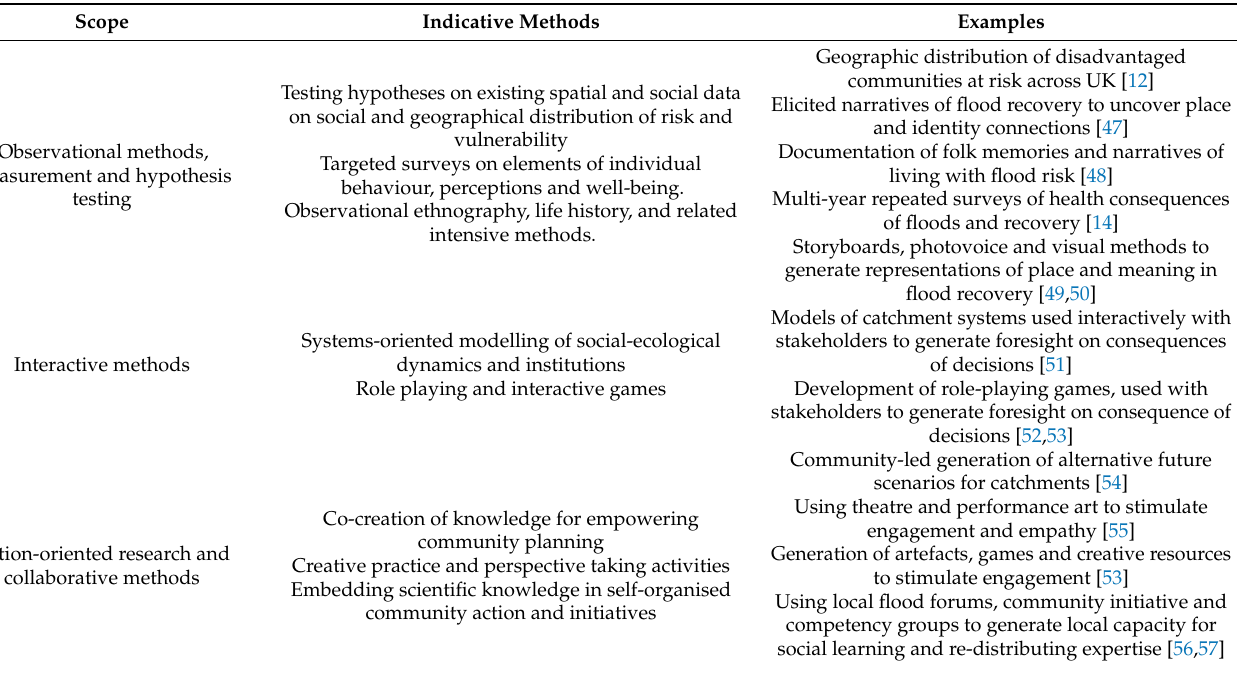
Table 2. Methods for measuring elements of resilience and action towards building